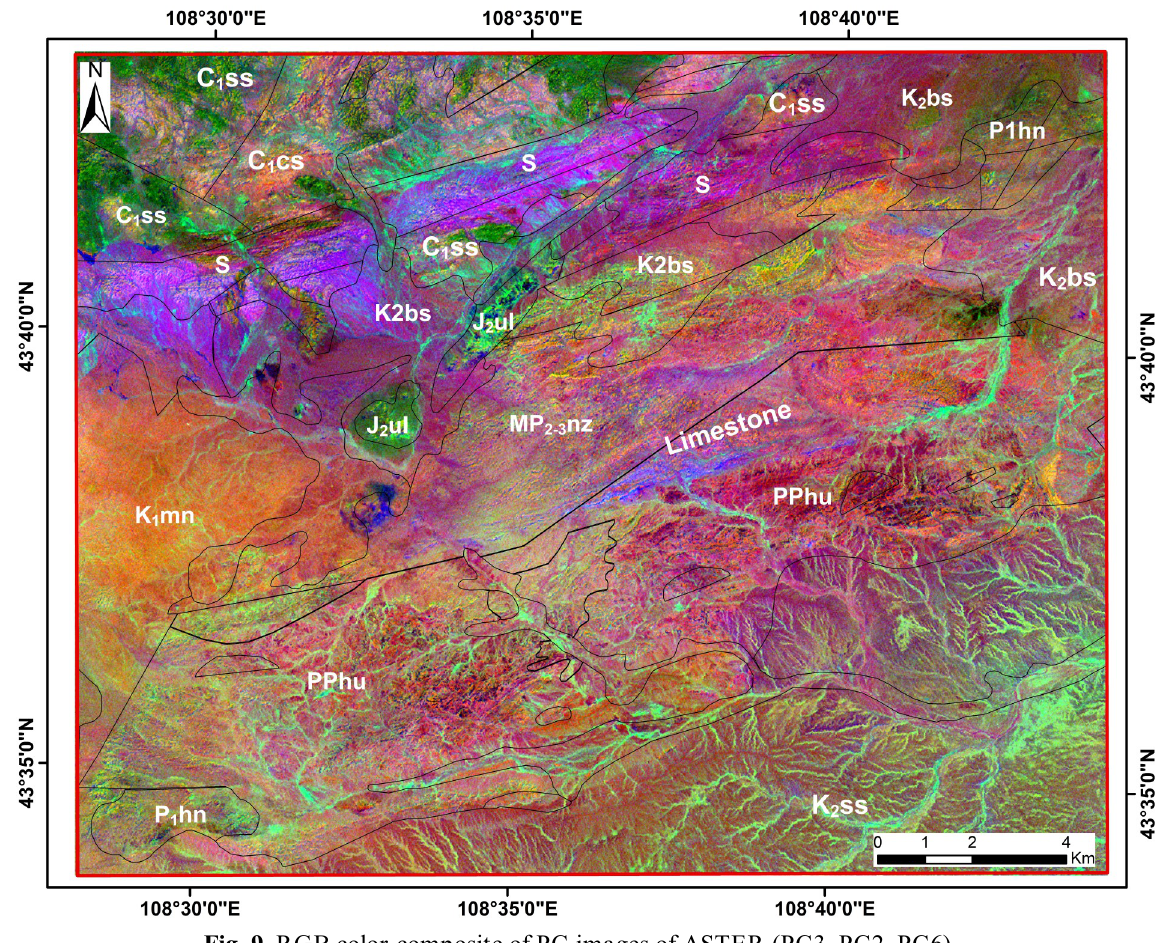
Fig. 9. RGB color composite of PC images of ASTER (PC3, PC2, PC6)